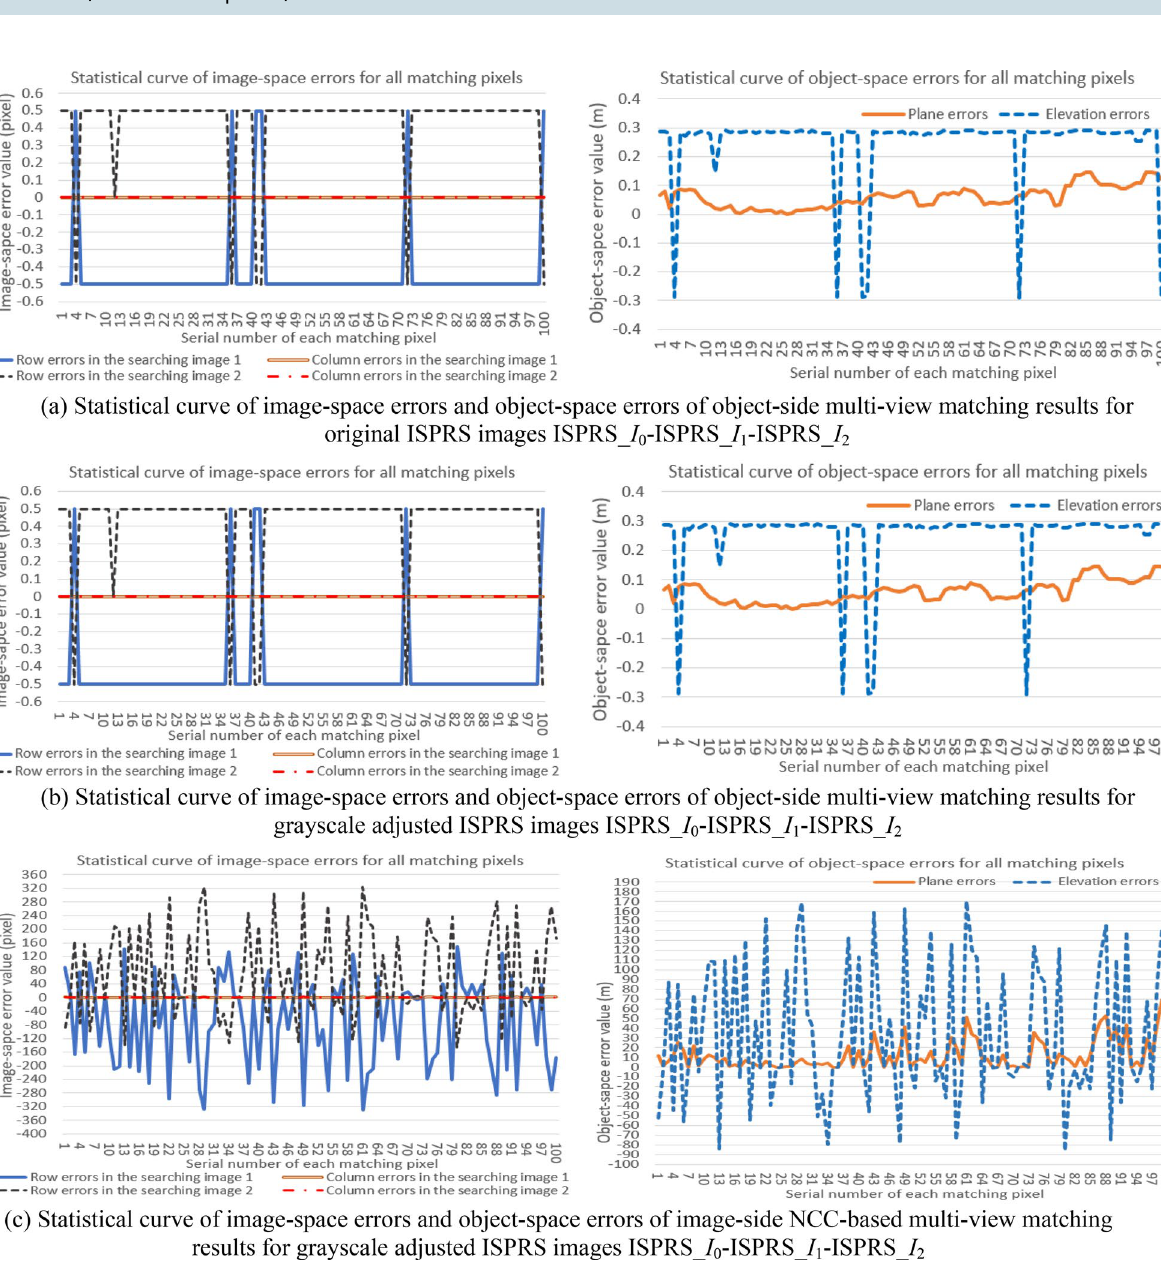
Figure 13. The comparative results of statistical curve of image-space errors (left column) and object-space errors (right column) of different multi-view matching results for original and grayscale adjusted ISPRS images (All these graphs were created by Microsoft Excel